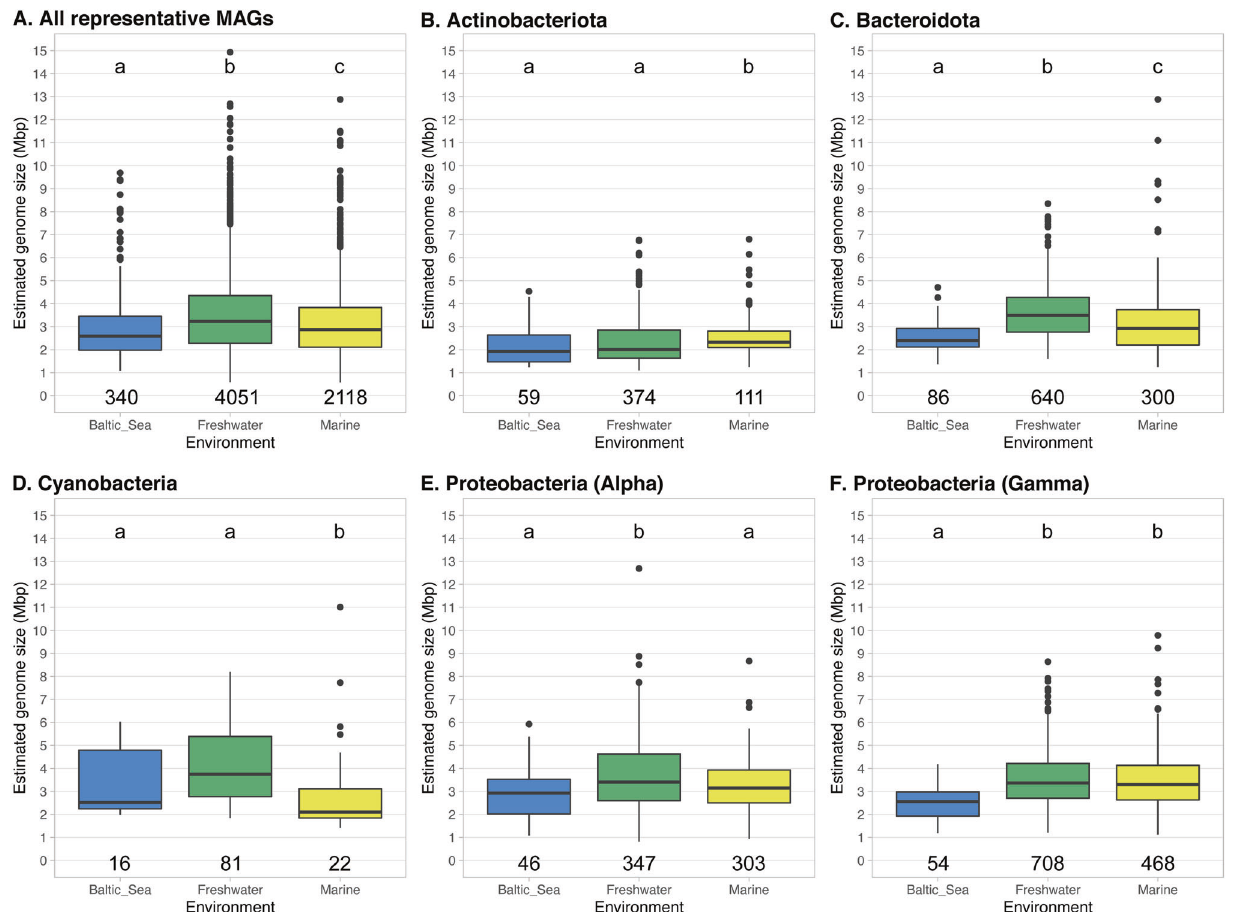
Fig. 4 Overview of the estimated genome size of pelagic Bacteria and Archaea obtained from Baltic Sea (blue), freshwater (green) and marine (yellow) using only representative MAGs (calculates using 95% average nucleotide identity) with >75% completeness. We compare all representative MAGs ( A ), only phylum Actinobacteriota ( B ), phylum Bacteroidota ( C ), phylum Cyanobacteria ( D ), class Alphaproteobacteria ( E ) and class Gammaproteobacteria ( F ). Different letters indicate signi fi cant differences p < 0.05 (Kruskal-Wallis non- parametric test; multiple testing corrected with Benjamini-Hochberg). Numbers below the boxes indicate the number of MAGs per